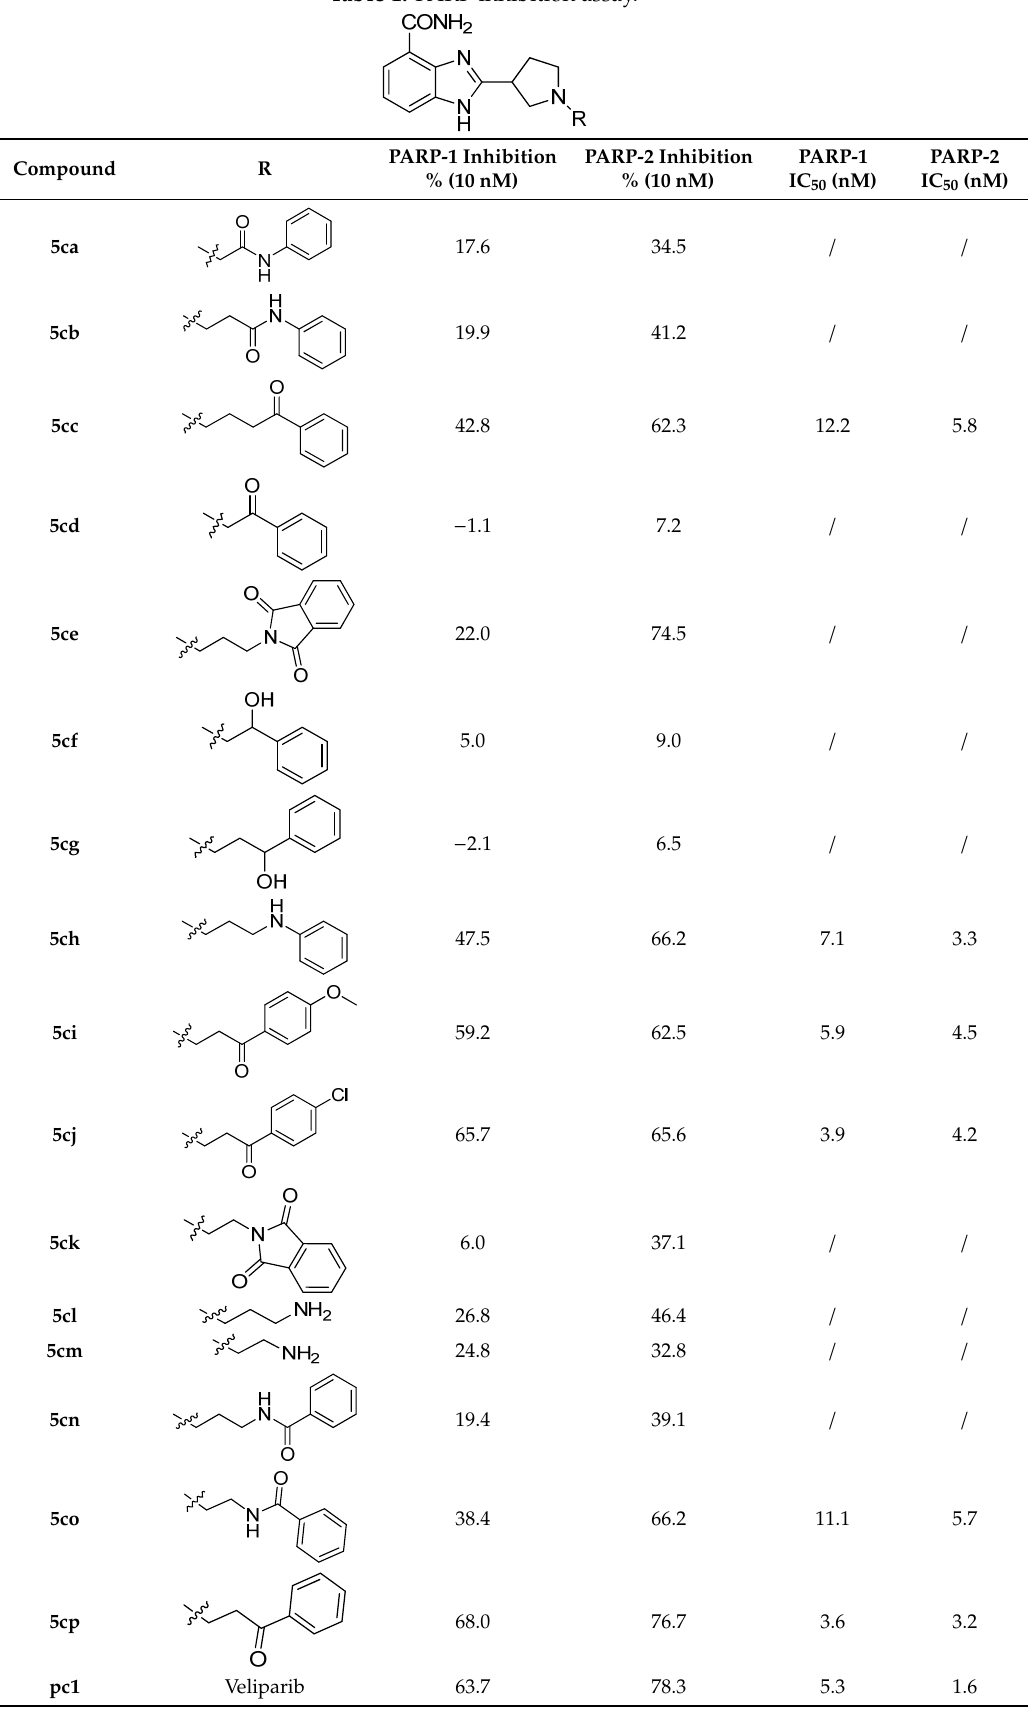
Table 1. PARP inhibition assay.